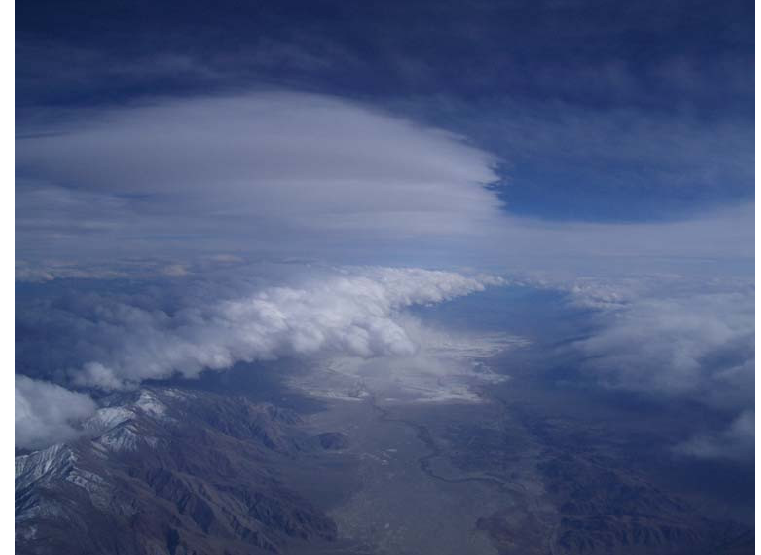
Figure 5. Photo of a severe downslope windstorm/rotor in Owens Valley showing dust lofted by downslope winds passing over the dry Owens Lake bed. The view is to the south, along the Owens Valley, with the westerly flow from right to left. Taken during T-REX IOP-6 from the FAAM BAe-146 research aircraft (credit: Dr Barbara Brooks, National Centre for Atmospheric Science).